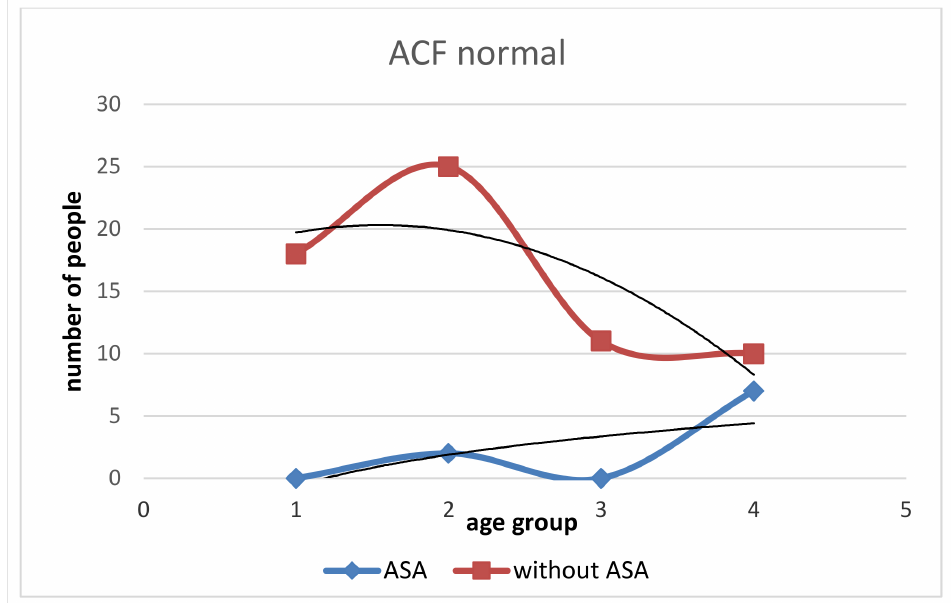
Figure 3. Incidence of ACF normal in the group with ASA and without ASA. In those without ASA, the number of ACF normally increases rapidly in the age group 50–60 years, then decreases from age 60 years. In the group with ASA, there is a lower number of ACF